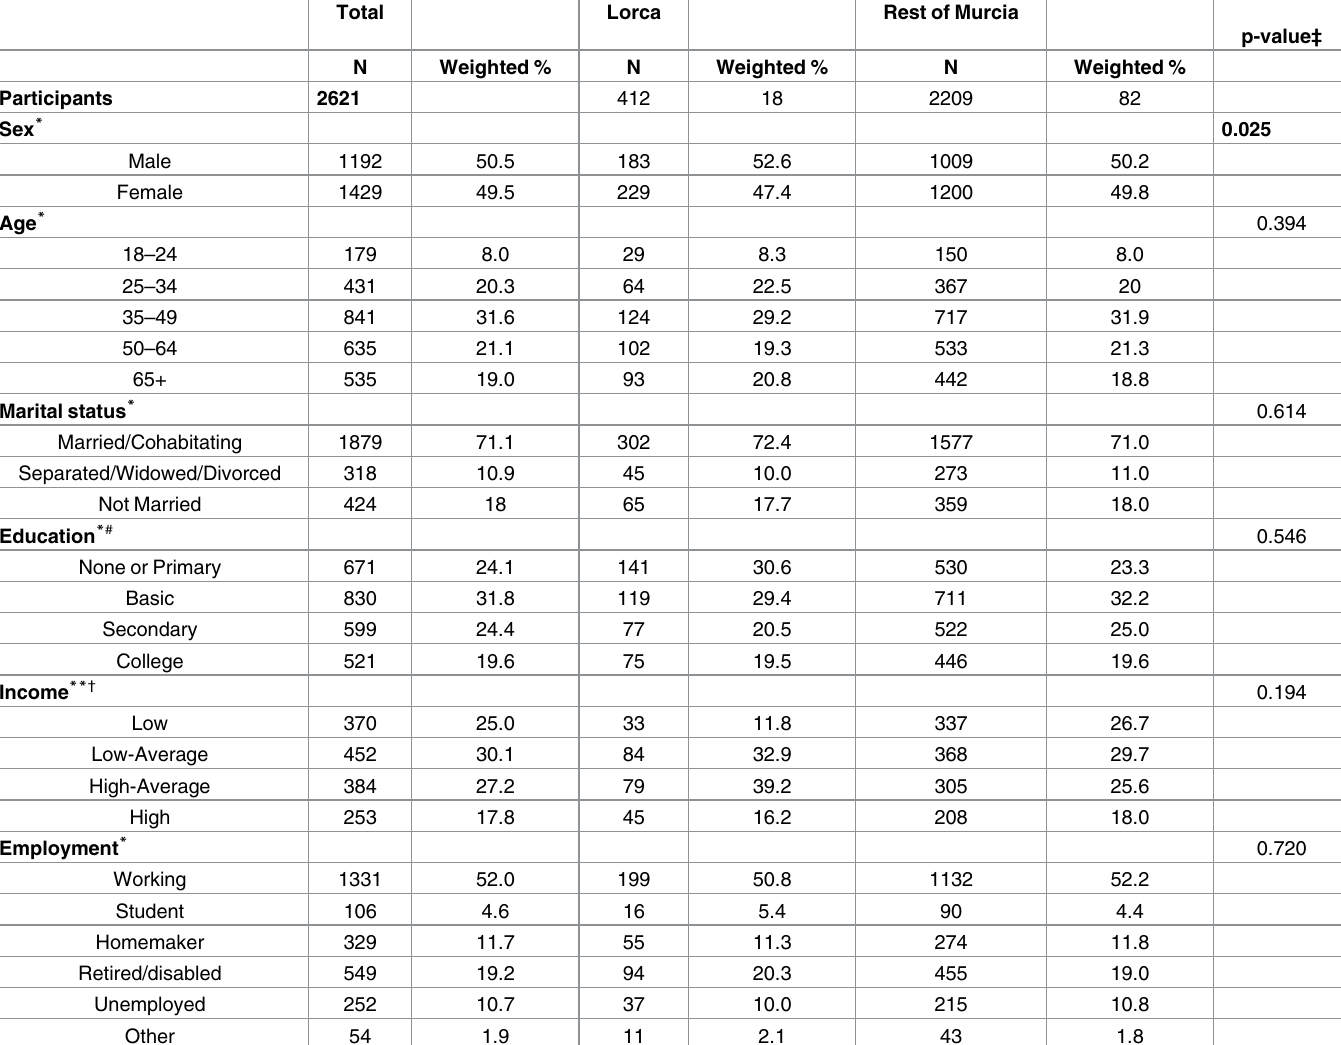
Table 1. Sociodemographic distribution of participants from Lorca and the rest of